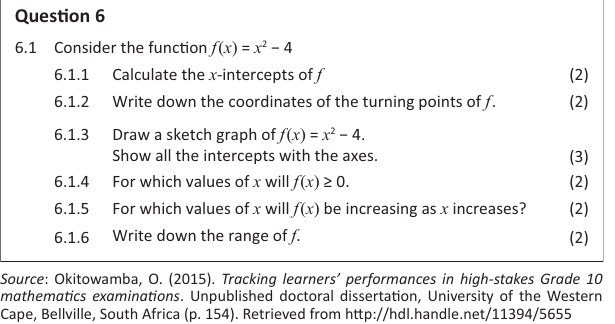
Source : Okitowamba, O. (2015). Tracking learners’ performances in high-stakes Grade 10 mathematics examinations . Unpublished doctoral dissertation, University of the Western Cape, Bellville, South Africa (p. 154). Retrieved from http://hdl.handle.net/11394/5655 FIGURE 2: Examination item on the quadratic function (the quadratic inequality item is 6.1.4).